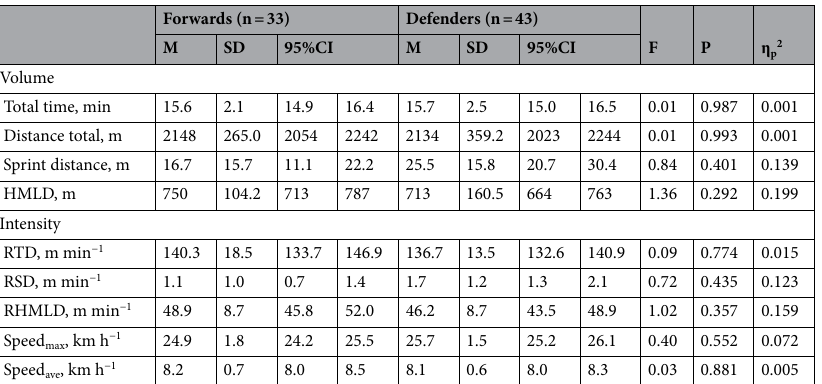
Table 3. Means (M), standard deviations (SD) and 95% confidence intervals (95% CI) for indicators of volume and intensity (per unit playing time) of effort by player position (forwards, defenders) during U16 Hockey5s matches, and results of the linear mixed model analysis and estimated effect sizes (η p2 ). HMLD, high metabolic load distance; RTD, relative total distance; RSD, relative sprint distance; RHMLD, high relative metabolic load distance.